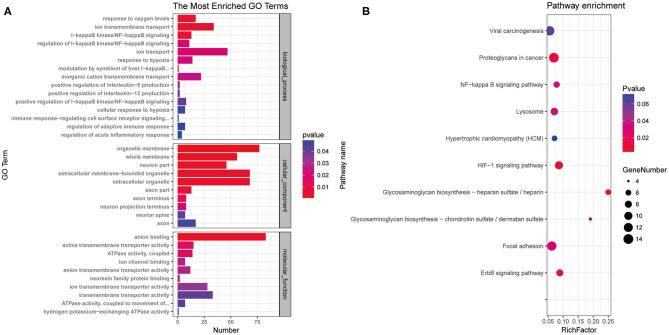
Gene Ontology annotation and Kyoto Encyclopedia of Genes and Genomes pathway analysis of differentially expressed microRNAs associated with potassium channels. (A) miRNAs were classified into three functional categories. Fifteen biological process annotations, 10 cellular component annotations, and 10 molecular function annotations were shown P < 0.05. (B) Top 10 Kyoto Encyclopedia of Genes and Genomes pathways P < 0.05.